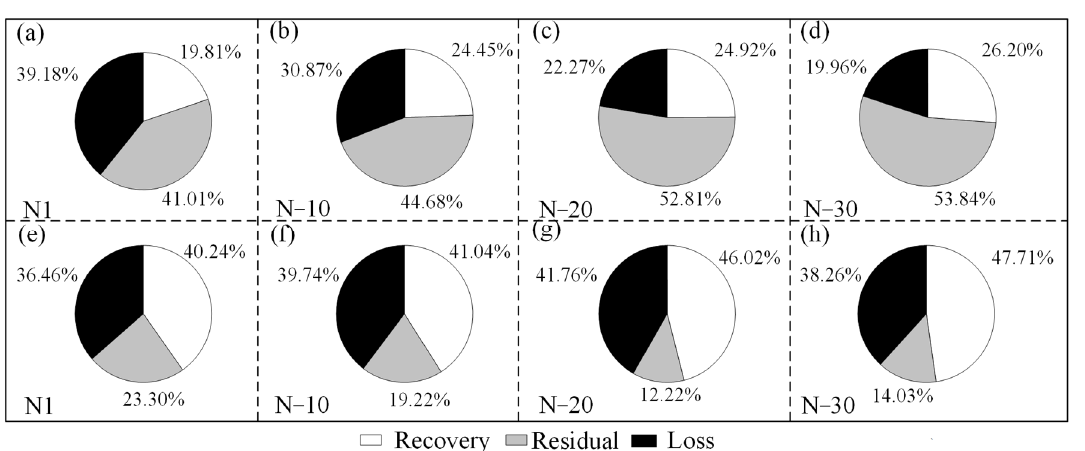
9 of 13 Figure 5. Nitrogen loss from basal fertilizer ( a ) and topdressing fertilizer ( b ). Note: different letters indicate significant differences ( p < 0.05). N0, N1, N − 10, N − 20 and N − 30 represent the five fertilization treatments. As shown in Figure 5b, the loss of topdressing decreased after nitrogen was reduced. There were no significant differences between the N1, N − 10 and N − 20 treatments ( p > 0.05). The loss of topdressing in the N ‐ 30 treatment was 26.55% lower than N1 treatment, representing significant differences ( p < 0.05). As shown in Figure 6, with the reduction in nitrogen application rates, the basal fertilizer recovery rates were improved, and the loss rates were reduced. With the reduction in nitrogen application rates, the recovery rates of topdressing improved, and the loss rates tended to increase first and then decrease. At the same time, although the